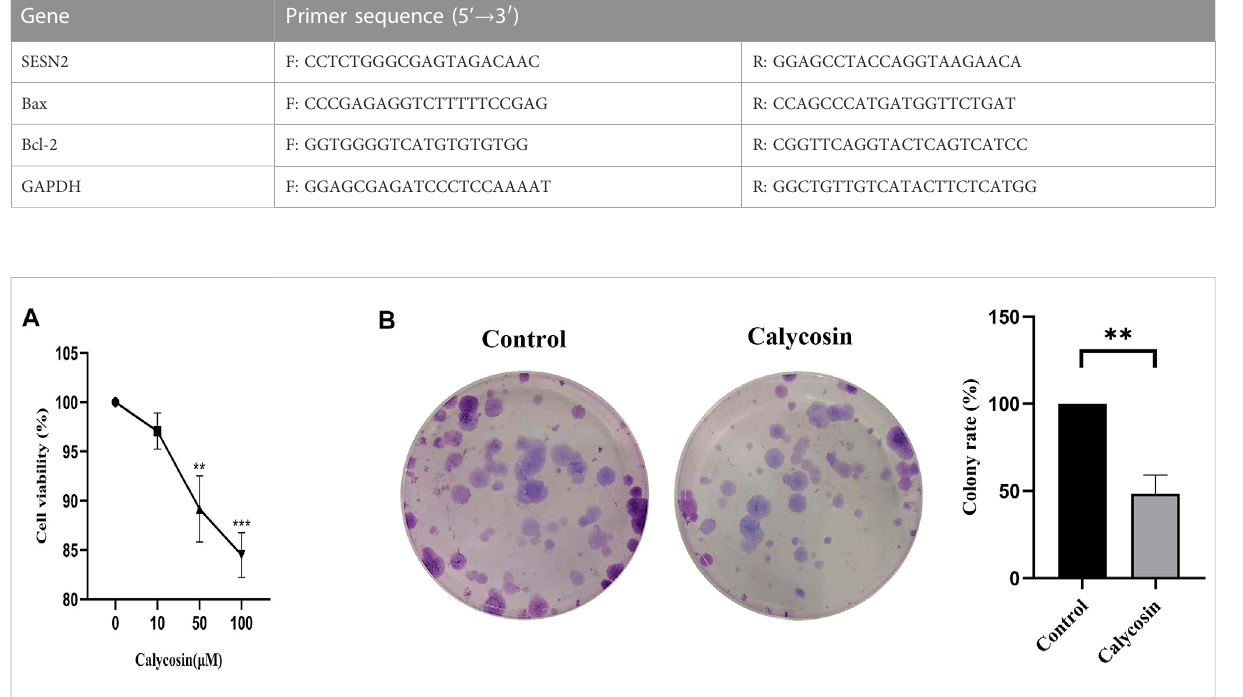
FIGURE 1 Calycosin inhibited the proliferation of B-CPAP cells. (A) CCK8 was used to measure the cell proliferation rate of BCPAP cells incubated with different concentrations of calycosin (0, 10, 50, 100 µM) for 24 h. (B) Colony formation assay was used to measure the number of clones formed in BCPAP cells incubated with calycosin (0, 100 µM) for 12 days. Results are representative of three independent experiments. * p < 0.05, ** p < 0.01,*** p <